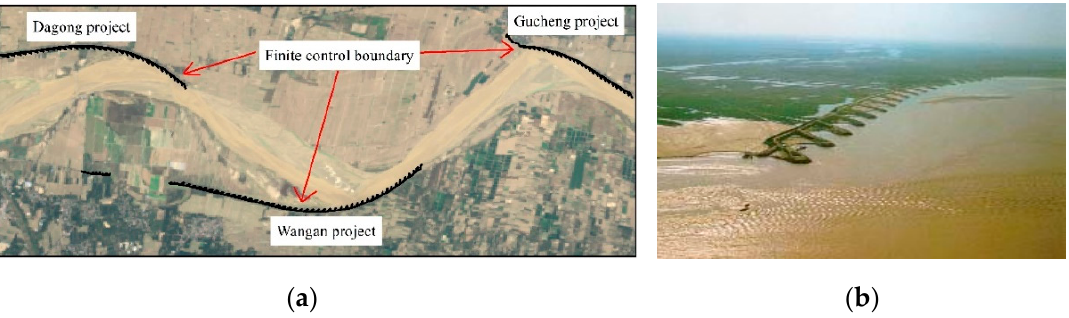
Figure 1. River channel with a finite control boundary: ( a ) Local reach in the lower Yellow River; ( b ) river regulation project in the lower Yellow River.